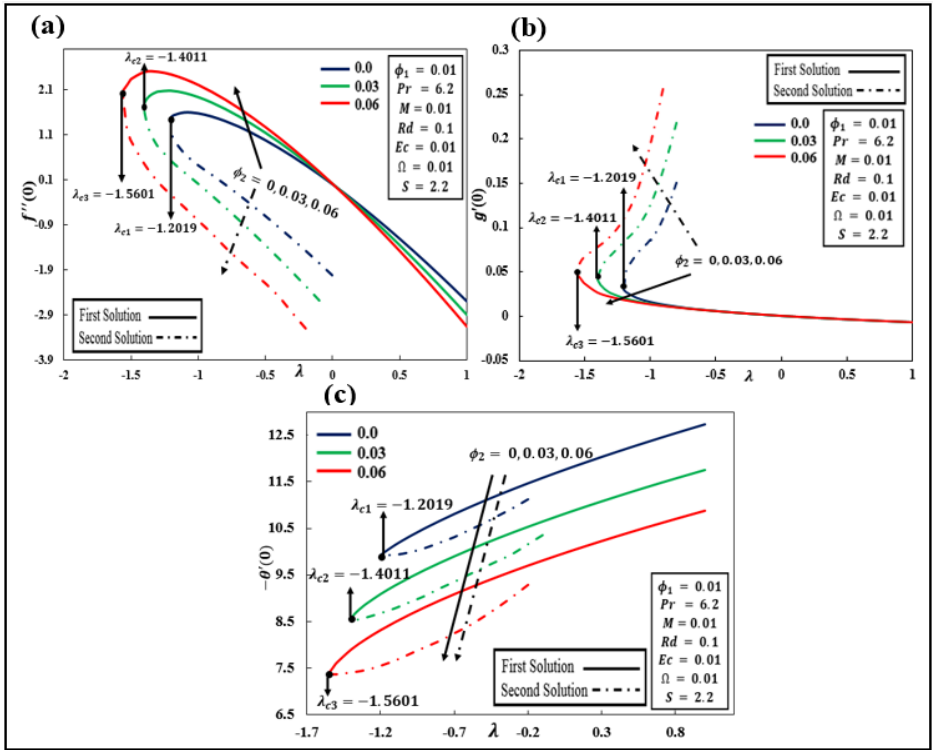
Figure 3. ( a − c ): Influence of 𝜙 (cid:2870) (𝐶𝑢) against stretching/shrinking (𝜆) on 𝑓′′(0) , 𝑔′(0) , and Figure 3. ( a – c ): Influence of φ 2 ( Cu ) against stretching/shrinking ( λ ) on f (cid:48)(cid:48) ( 0 ) , g (cid:48) ( 0 ) , and − θ (cid:48) ( 0 ) −𝜃′(0) . Figure 4a–c depicts different values of 𝑀 = 0, 1, and 3 when the velocity and temper- ature profiles are (𝑓 (cid:4593) (𝜂),𝑔(𝜂)) and 𝜃(𝜂), respectively, under different parameters, such as 𝜙 (cid:2869) = 0.01, 𝜙 (cid:2870) = 0.03, 𝑃𝑟 = 6.2,𝑆 = 1.9, 𝑅𝑑 = 𝐸𝑐 = 0.1, Ω = 0.01, and 𝜆 = −1 . Fig- ure4a illustrates that 𝑓 (cid:4593) (𝜂) profiles decrease with an upsurged value of 𝑀 in both (first and second) solutions due to the high drag force created by the magnetic number. The effect of 𝑀 on 𝑔(𝜂) profiles is shown in Figure 4b. It is observed that 𝑔(𝜂) profiles re- duce with an upsurged value of 𝑀 in both solutions. Figure 4c shows that 𝜃(𝜂) in- creases as the value of 𝑀 increases in both solutions. As a consequence, the influence of heat transfer is increased as 𝑀 increases. The Lorentz force, which is caused by the mag- netic field, makes the rate of transfer less resistant [49]. The plots of the velocity profile (𝑓 (cid:4593) (𝜂),𝑔(𝜂)) andthe temperature profile 𝜃(𝜂) against solid nanoparticle volume fractions 𝜙 (cid:2870) = 0.02,0.04, and 0.06 of copper are por- trayed in Figure 5a–c, respectively. Figures 5a shows that in thefirst and second solutions, the fluid velocity 𝑓 (cid:4593) (𝜂) decreases when the value of 𝜙 (cid:2870) is enhanced. From Figure 5b, the 𝑔(𝜂) profile in both solutions declines with a growing value of 𝜙 (cid:2870) . Figure 5c show that in the first and second solutions, the temperature profile 𝜃(𝜂) increases when the value of 𝜙 (cid:2870) is enhanced. Figure 6 illustrates the value of 𝐸𝑐 at a different point for the temperature profile 𝜃 (𝜂) . In the first and second solutions, the values of 𝐸𝑐 increase, causing 𝜃 (𝜂) to rise as